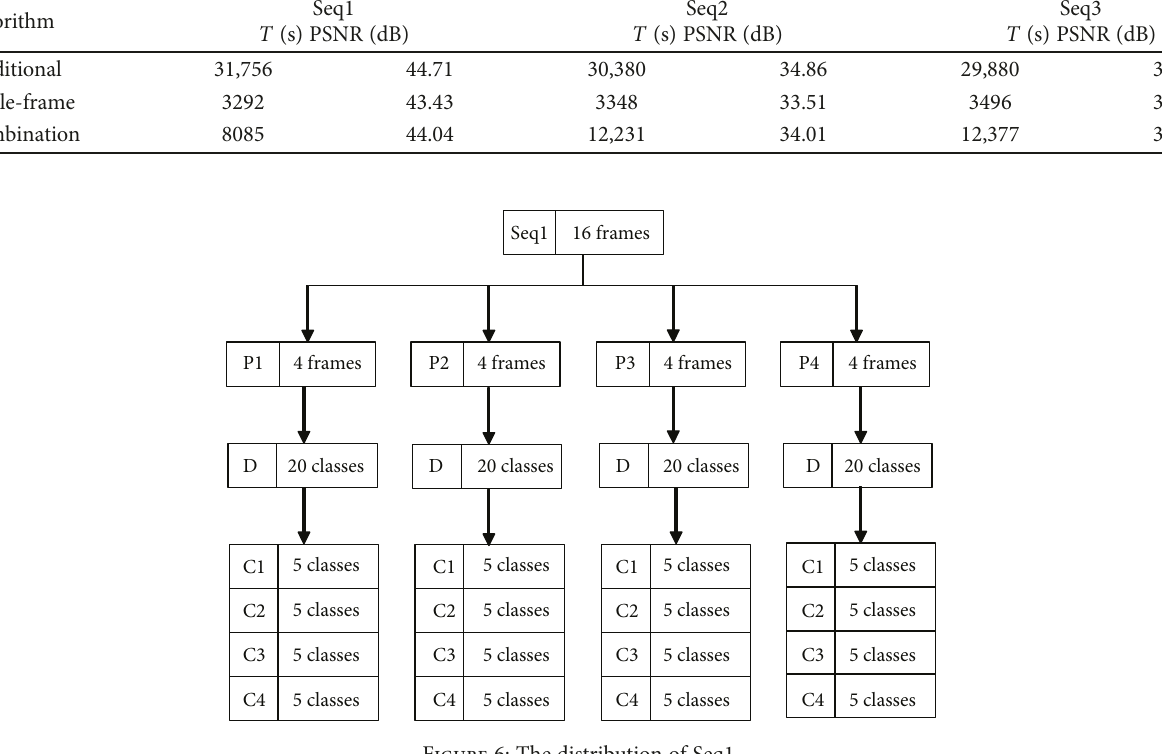
Figure 6: The distribution of Seq1.